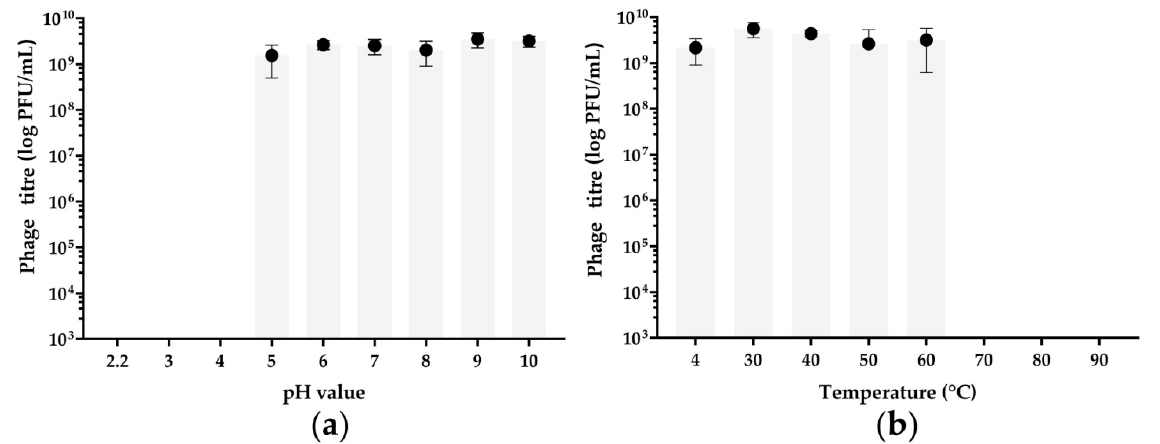
Figure 3. Thermal and pH stability of Pseudomonas phage Pf-10. ( a ) Phage survival after 1-h incubation at pH values ranging from 2.2 to 10. ( b ) Phage survival after 1-h incubation at the temperatures ranging from 4 to 90 °C. The graphs were created with GraphPad Prism 8.4.3. Values represent the mean of three independent trials, and error bars represent the standard deviation.